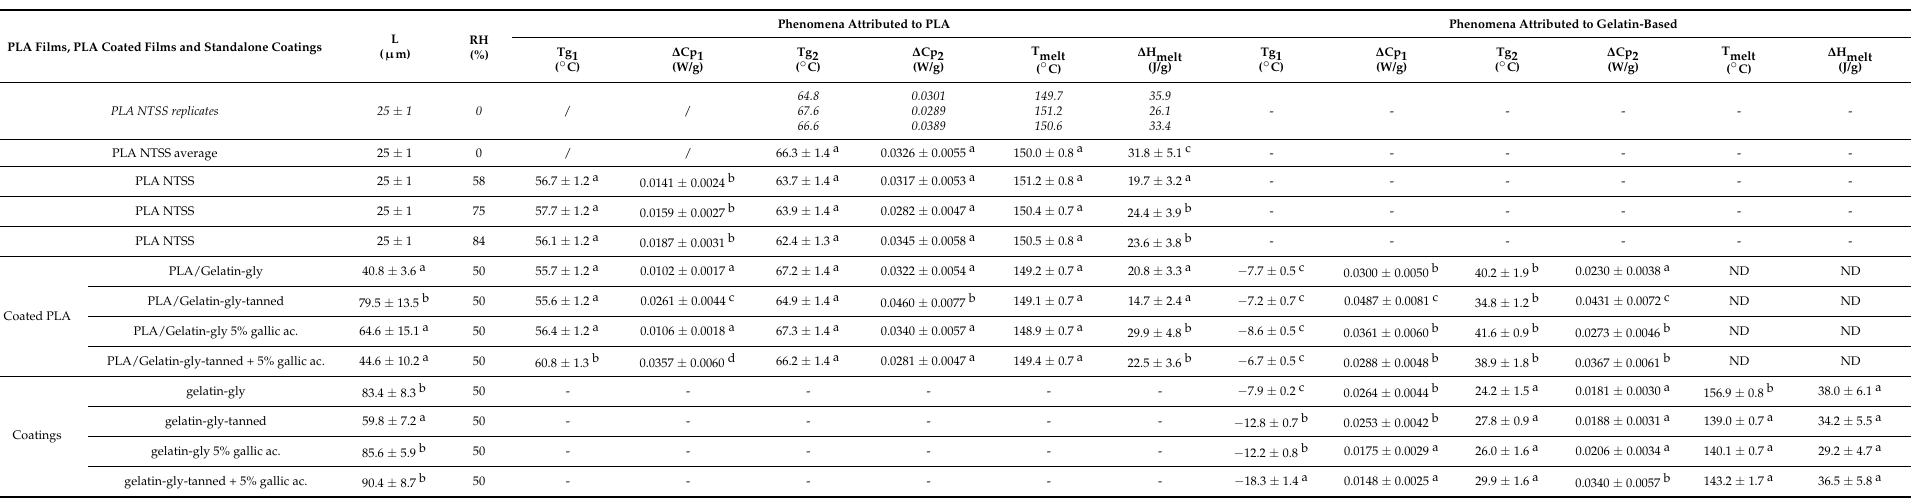
Table 2. Thermal characteristics of PLA films according the relative humidity, and of both the standalone coatings and PLA coated films (L, thickness; RH, relative humidity; T g , glass transition temperature; ∆ C p , the specific calorific capacity variation of T g ; T melt , melting temperature and ∆ H melt , the melting enthalpy). PLAFilms,PLACoatedFilmsandStandaloneCoatings